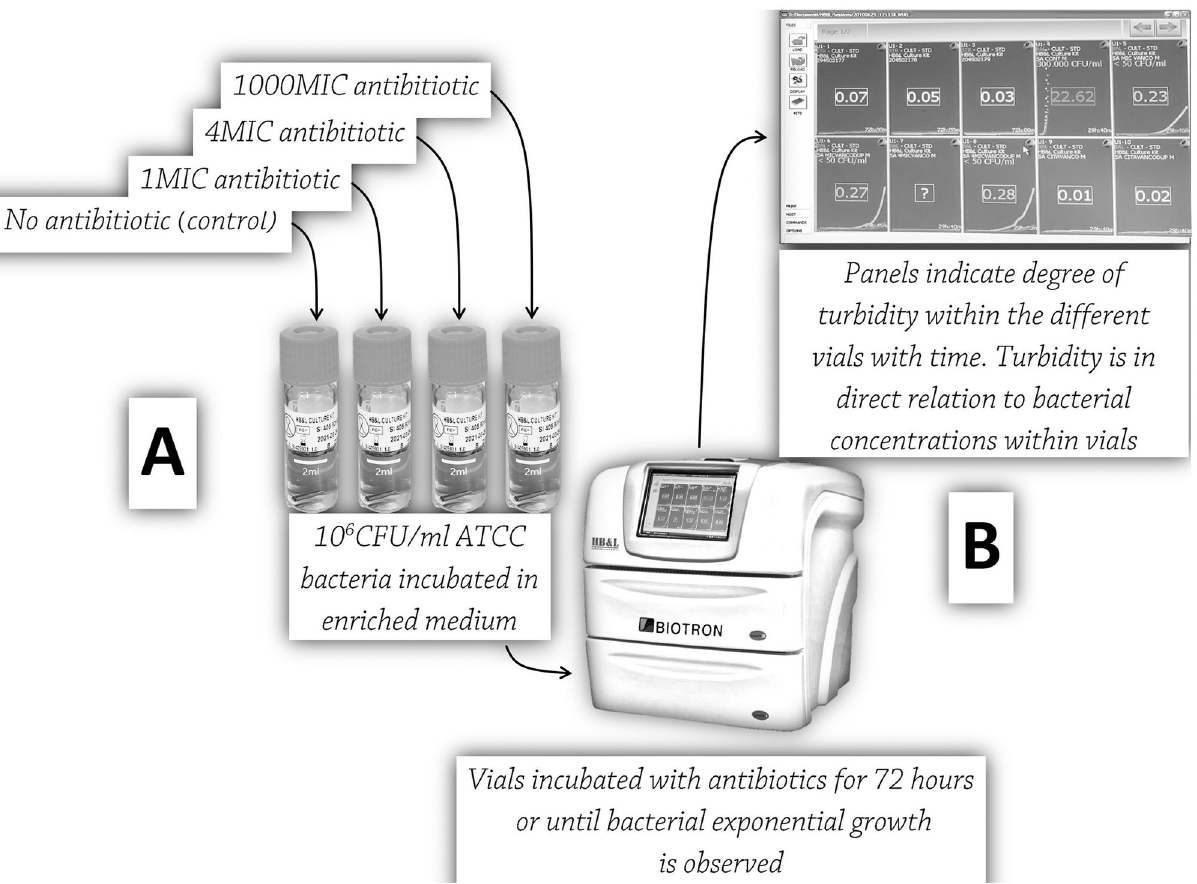
Fig 1. Study design scheme: (A). Vials containing ATCC bacteria at a concentration of 10 6 colony forming units (CFU/ml) were incubated in enriched medium and different antibiotic concentrations; (B). Turbidity measured by the HB&L system within the vial indicating the time of bacterial exponential